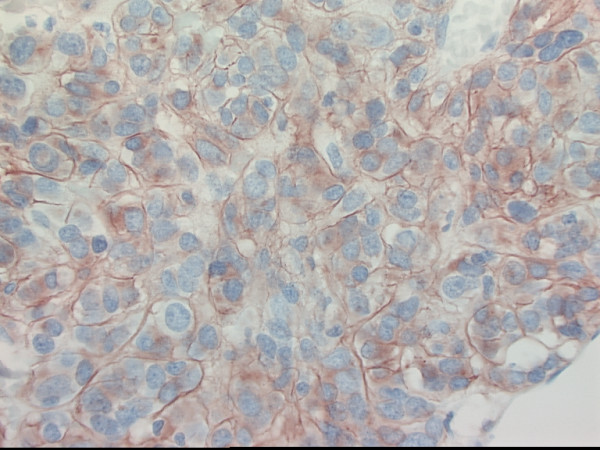
Immunohistochemical stain for CD117 (c-kit) showing staining of the cell membrane and Golgi region of the tumor cells, (× 400)